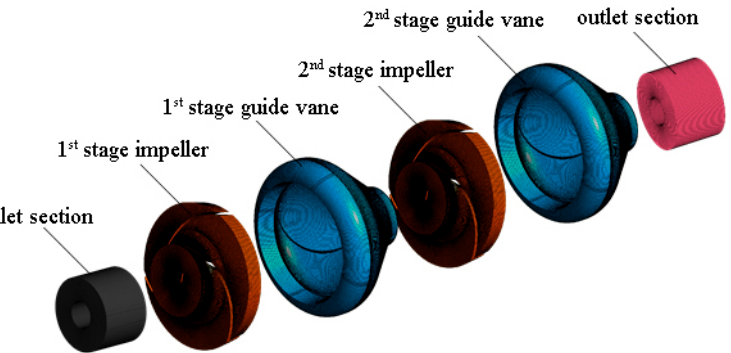
Figure 2. Model pump computational domain meshes.